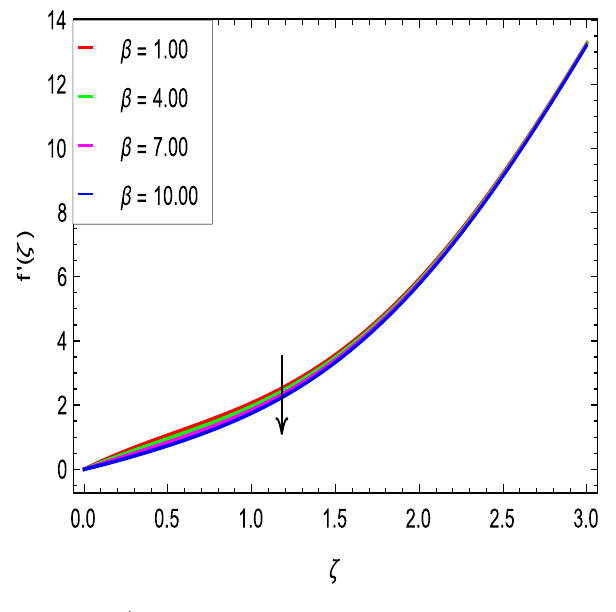
Figure 4. f ′ (ζ) in terms of β .